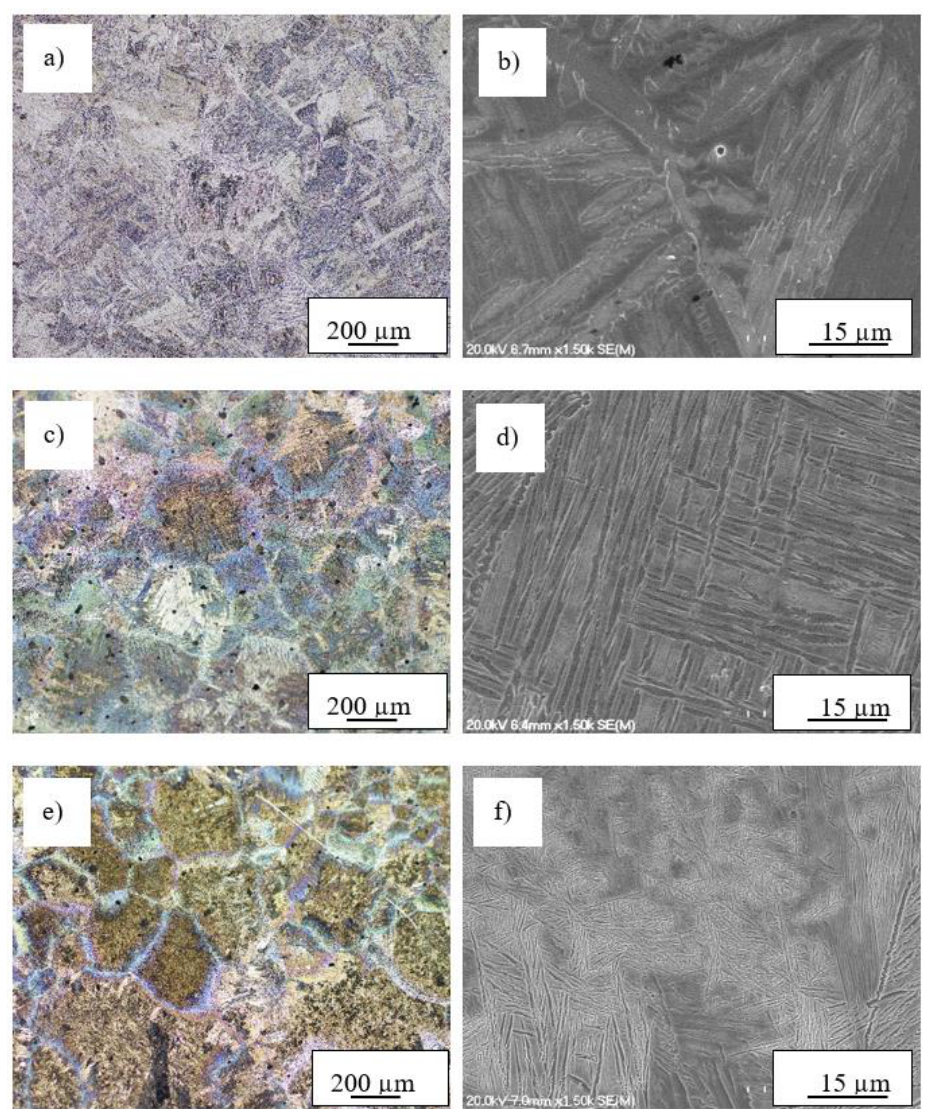
Figure 4. Optical and SEM micrographs, respectively, of the Ti-5Fe-xNb alloys: ( a , b ) Ti-5Fe-2Nb, ( c , d ) Ti-5Fe-6Nb, and ( e , f ) Ti-5Fe-9Nb.